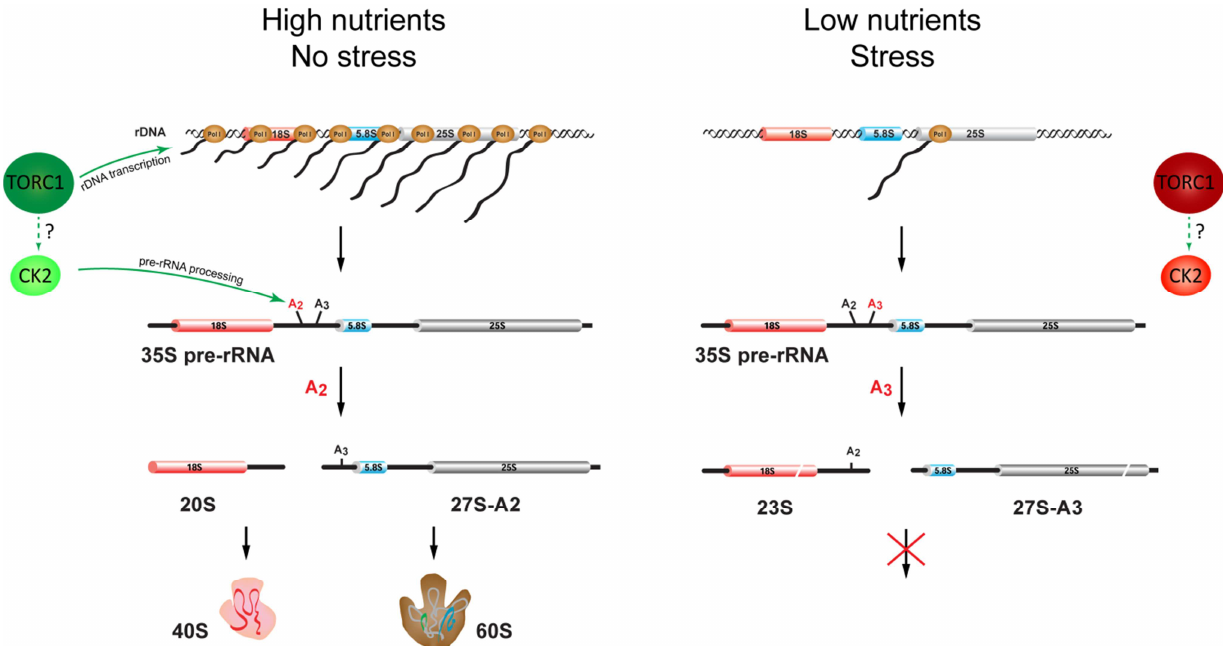
Figure 1: Alternative pathways of the pre-rRNA processing in yeast. Left: When nutrients are available and no environmental stress is pre- sent, TORC1 and CK2 kinase are active, promoting high level of rDNA transcription, cleavage of the pre-rRNA at the site A2 and maturation of new ribosomes. Right: In the condition with low nutrients or stress, both TORC1 and CK2 are inactive. The transcription of rDNA is reduced and pre-rRNA is cleaved at the site A3 and no new ribosomes are